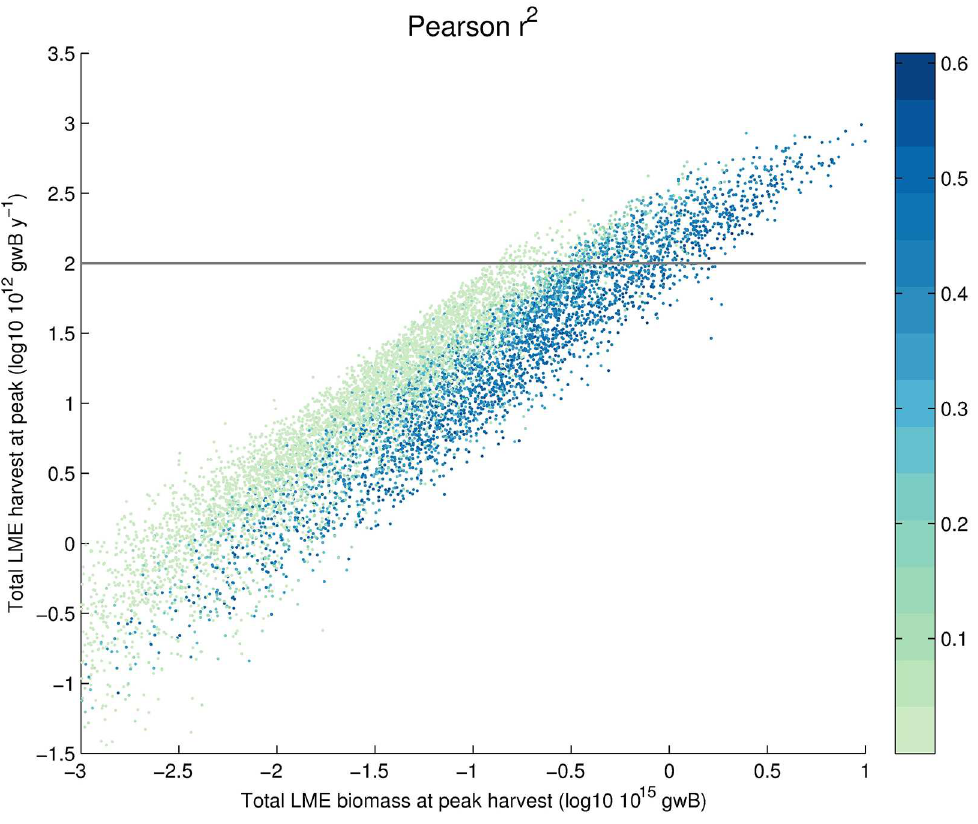
H sim ) i Globalmax H sim ) comparedto the peak i ; l LMEmax H obs ). The grey line represents a reference global l LMEmax